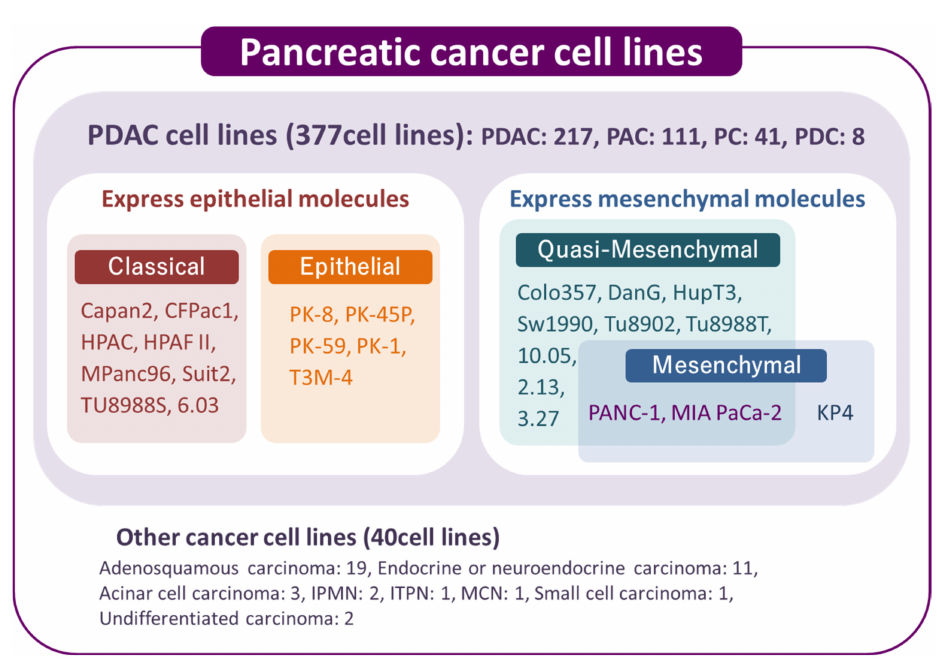
Figure 1. Pancreatic cancer cell lines listed in the